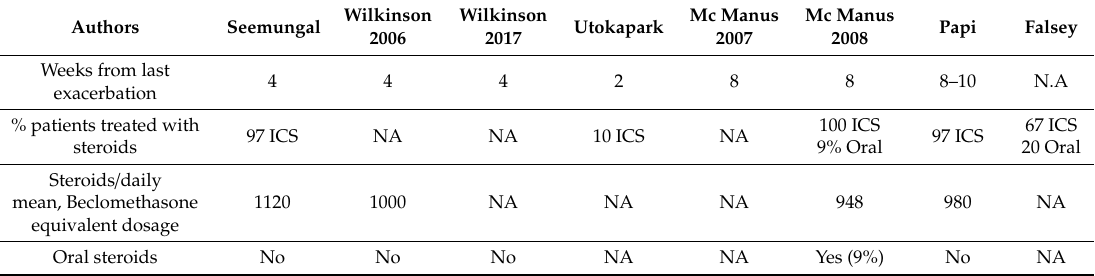
Table 6. Principal selection criteria and treatments used in some relevant